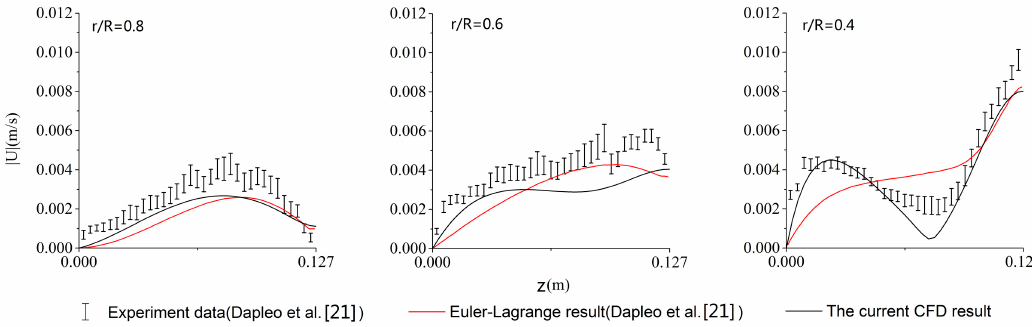
Figure 5. Comparison of the time-averaged velocity magnitude results along a vertical axis between the numerical simulation and particle image velocimetry (PIV) [21].